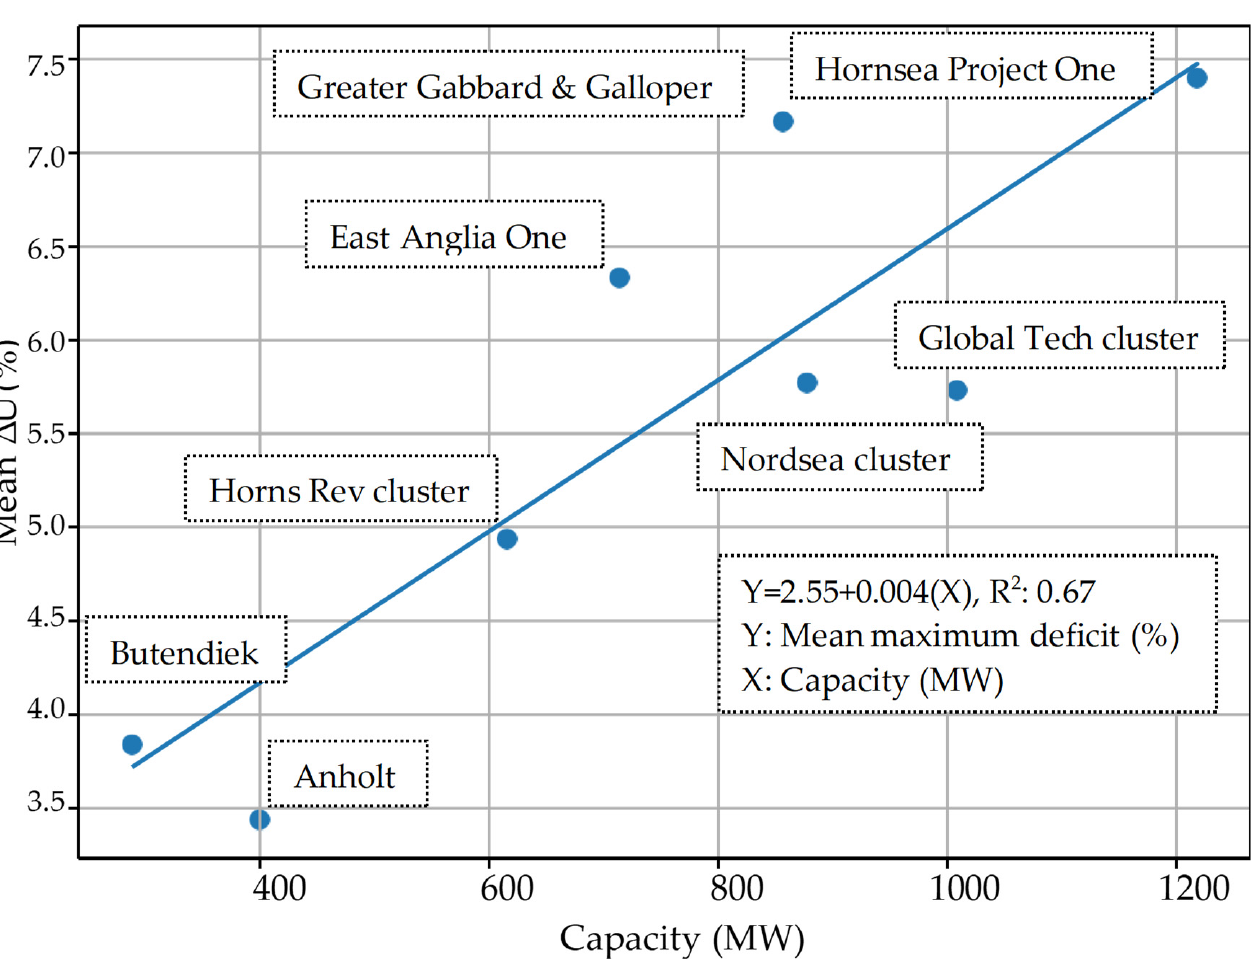
Figure 13. The average maximum velocity deficit (𝛥𝑈) for westerly, easterly, and southerly winds; average maximum Δ U in Table 4 vs. the capacity of OWFs and clusters.